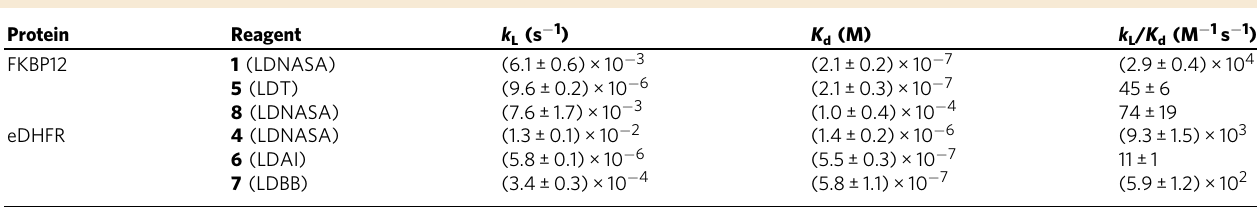
The data represent the mean of triplicate±standard